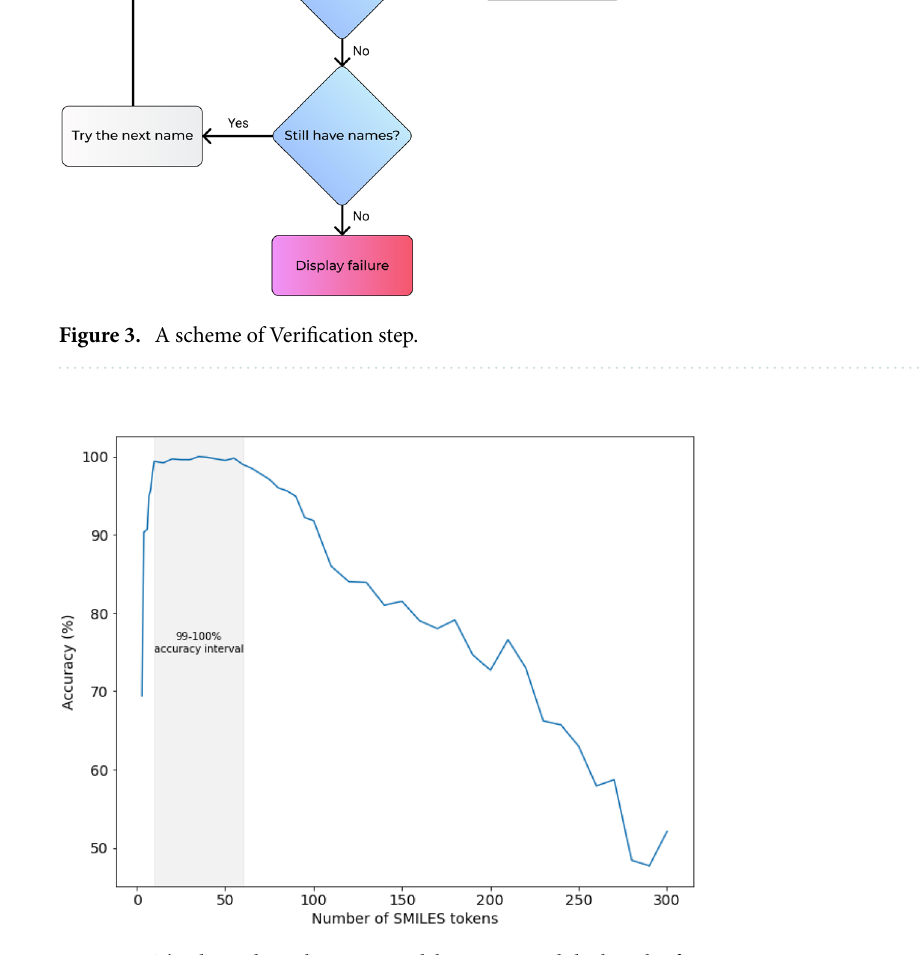
Figure 4. The dependence between model accuracy and the length of